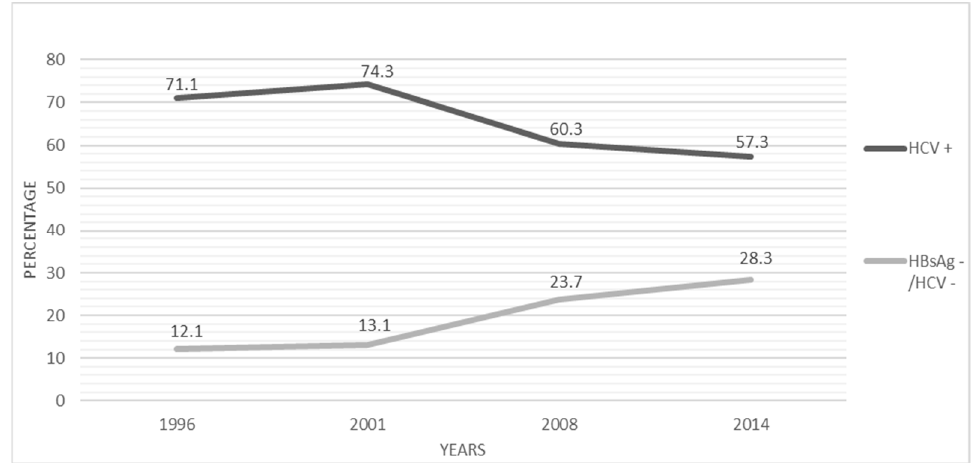
Figure 1. Temporal trends of the proportion (%) of anti-HCV positivity and hepatitis viruses negativity among HCC patients in Italy, 1996–2014. Adapted from Reference 68. (X 2 for linear trend = p < 0.001).